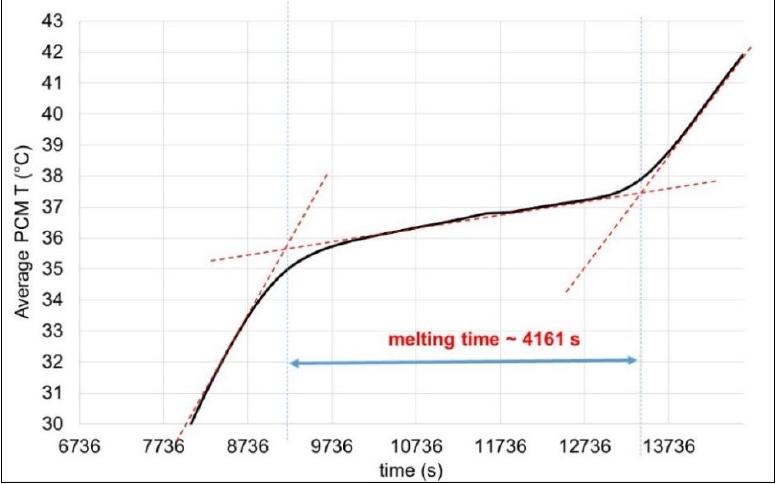
Figure 12. Average external temperature of the cells experimentally observed with P = 0.55 W/cell.